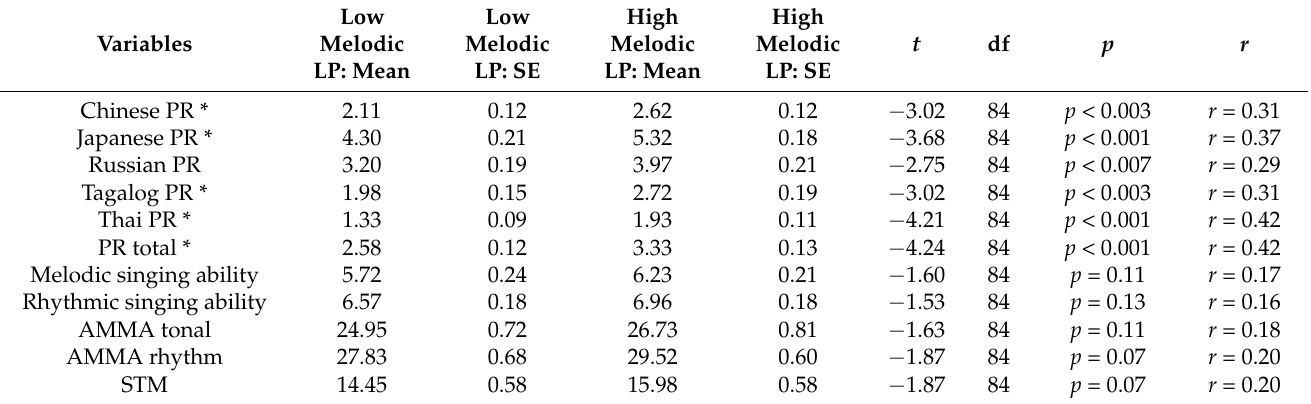
Table 5. Independent t -tests of the high melodic language perceivers and the low melodic language perceivers.